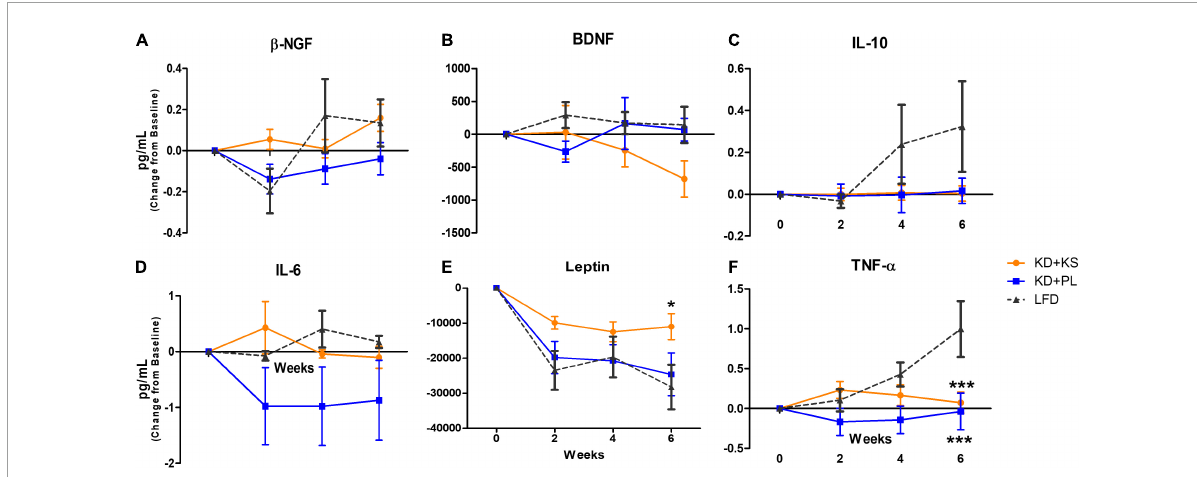
FIGURE5 Quantification of adipokine biomarkers in human plasma in all diet groups. Results are presented (in pg/mL) as change ( ± SEM) from baseline values. (A) β -NGF, (B) BDNF, (C) IL-10, (D) IL-6, (E) Leptin, and (F) TNF- α . KD, ketogenic diet; KS, ketone supplement; PL, placebo; LFD, low-fat diet. Data included in Supplementary Table 1 but not shown in this figure: IL-6, IL-8, IL-1 β , and MCP-1. * p < 0.05 vs. LFD, *** p < 0.001 vs.